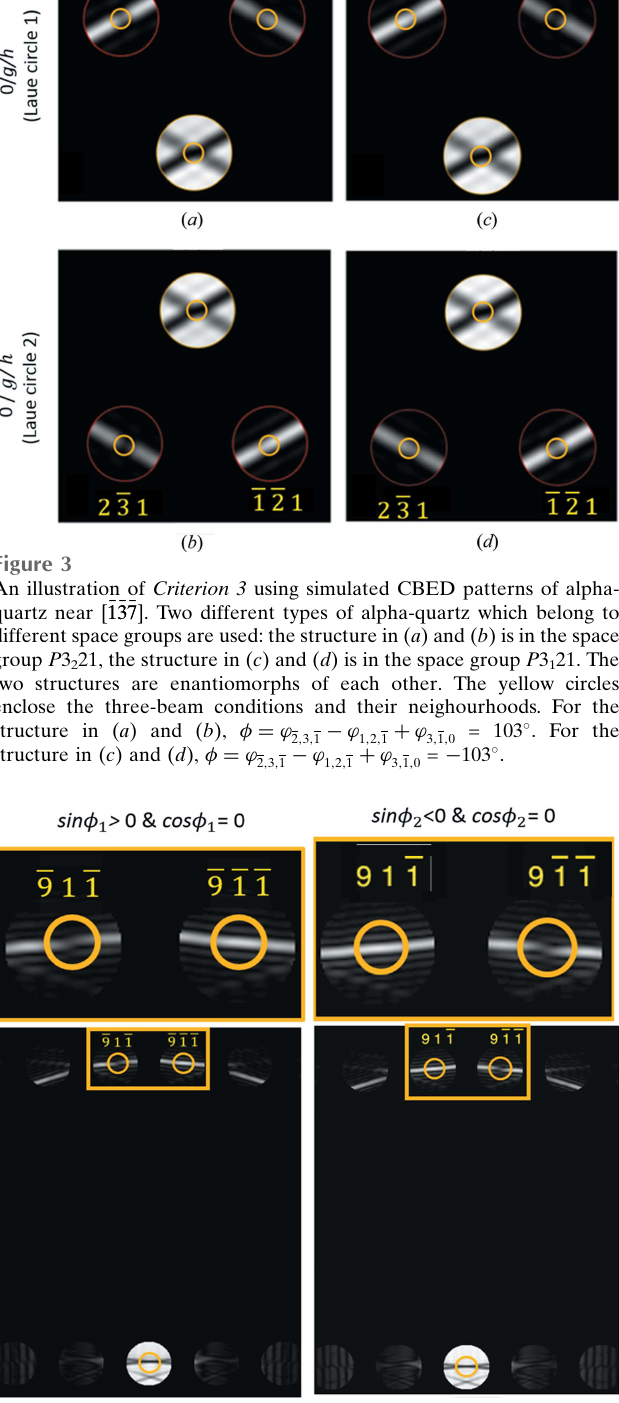
Figure 4 Illustrations of Criteria 3 and 4 in CBED patterns with Bijvoet pairs satisfying the three-beam conditions. The CBED patterns were simulated for GaAs in the zone axes ( a ) [10 9] and ( b ) [109]. The three-beam conditions of interest are circled. An enlarged view of reflections g and h ¼ ’ (yellow boxed region) is also shown. Note that (cid:2) 1 9 ; 1 ; 1 þ ’ (cid:4) ’ ¼ 90 (cid:3) and (cid:2) ¼ ’ þ ’ (cid:4) ’ = (cid:4) 90 (cid:3) 0 ; 2 ; 0 2 0 ; 2 ; 0 9 ; 1 ; 1 9 ; 1 ; 1 9 ; 1 ; 1